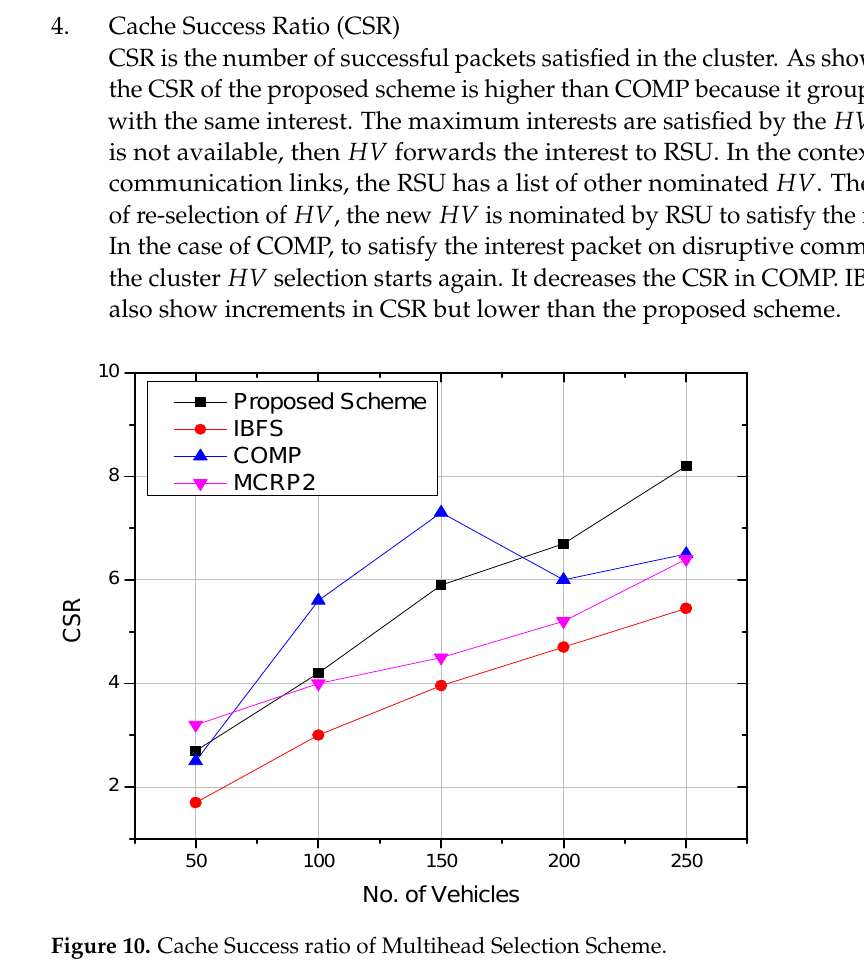
Figure 9. Interest packet Drop Fraction of Multihead Selection Scheme.